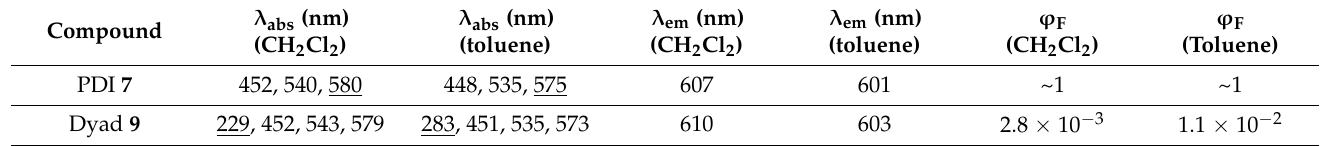
Table 2. Absorption spectra in CH 2 Cl 2 and toluene for PDI 7 and dyad 9 (C = 10 − 5 M): λ max is under- lined. Emission spectra in CH 2 Cl 2 and toluene for PDI 7 and dyad 9 ( λ exc = 520 nm; C = 5 × 10 − 6